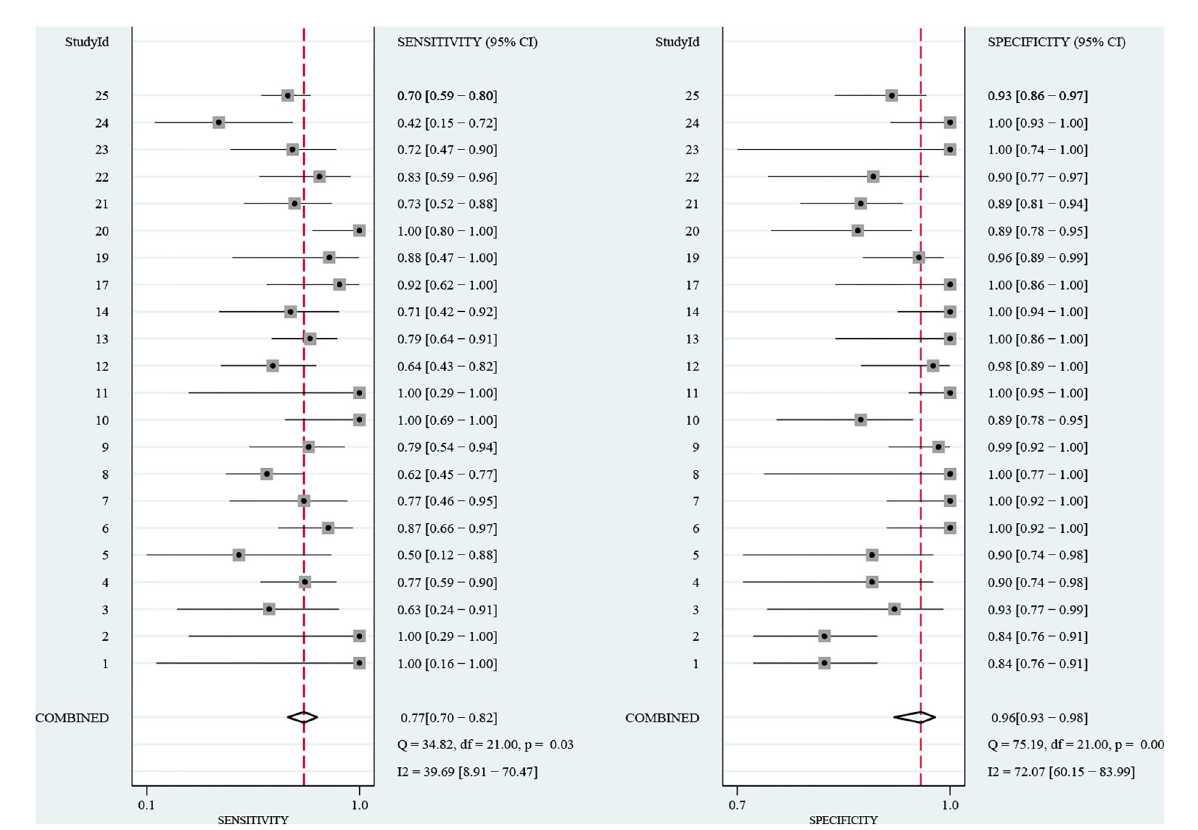
FIGURE4 Forest plot for the sensitivity and specificity of mNGS for the diagnosis of CNS